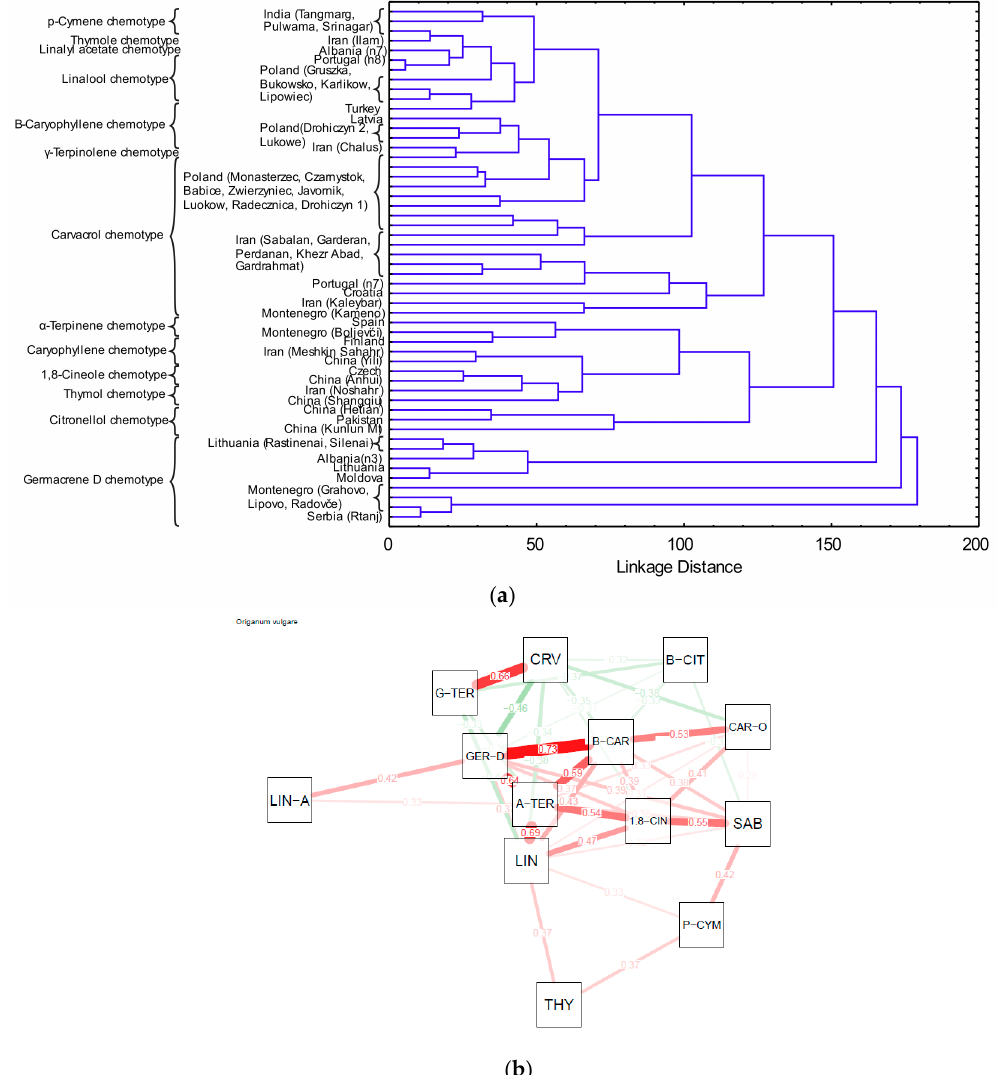
Figure 3. ( a ) Dendogram of the EO constituents of O. vulgare from this study and from literature reports (the samples are marked according to Table 5); ( b ) correlation network based on O. vulgare EO constituents (P-CYM— p -cymene; THY—thymol; CRV—carvacrol; SAB—sabinene; G-TER— γ -terpinene; 1,8-CIN—1,8-cineole; LIN—linalool; A-TER— α -terpineol; B-CIT— β -citronellol; LIN-A—linalyl acetate; B-CAR— β -caryophyllene; GER-D—germacrene D; CAR-O—caryophyllene